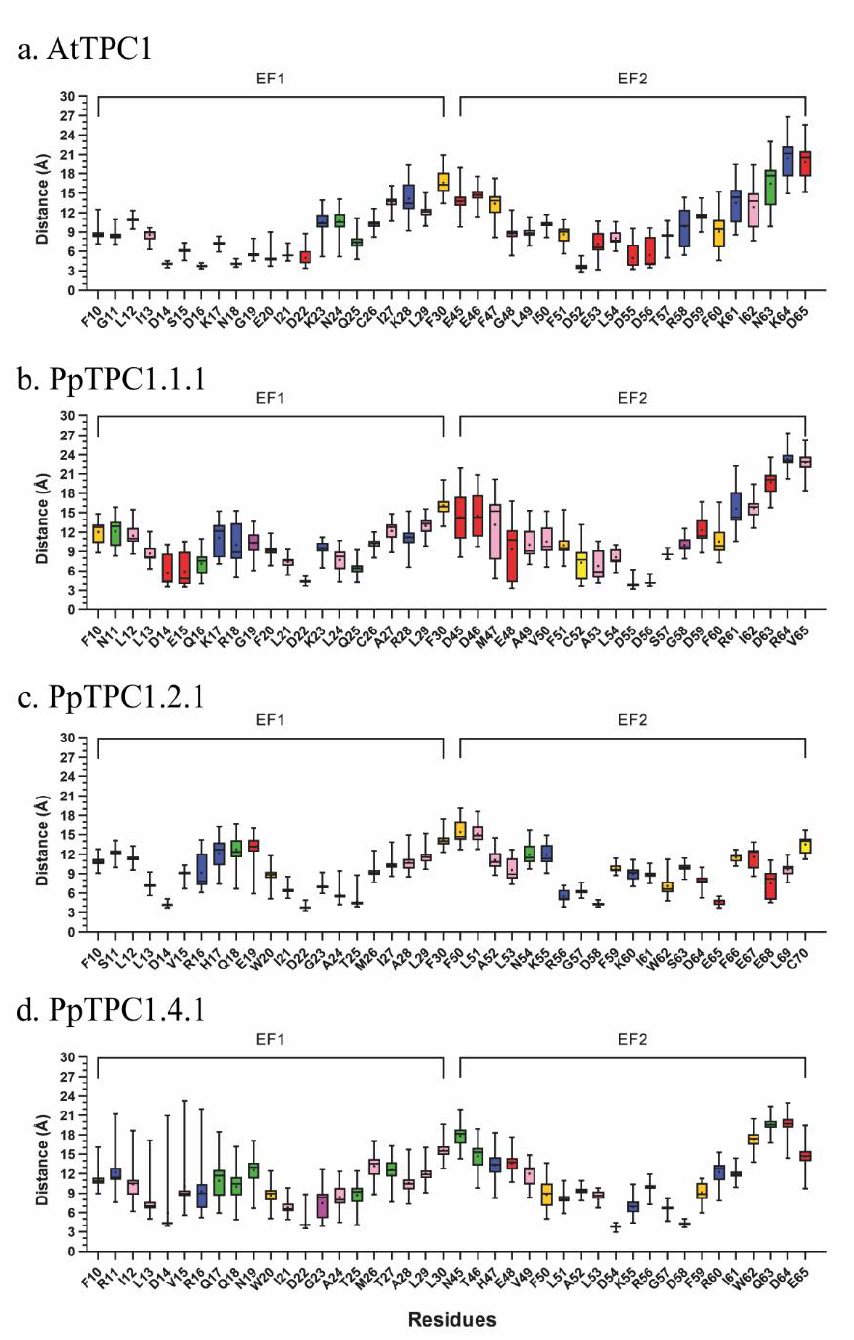
Figure 7. Distribution of distances between each residue and Ca 2+ . Boxplots show the distances between calcium and the center of mass of the residues in the vicinity of the EF-hand binding sites from ( a ) AtTPC1, ( b ) PpTPC1.1.1, ( c ) PpTPC1.2.1, and ( d ) PpTPC1.4.1. Zappo staining was used to distinguish the characteristics of the residues: red: negatively charged, blue: positively charged, green: polar, ochre: aromatic, pink: hydrophobic, yellow: cysteine, and magenta: proline and glycine. For both the EF1-hand and the EF2-hand, the box amplitude indicated the dispersion of the distances, where the greater dispersion indicated a more significant absence of Ca 2+ binding and vice versa.